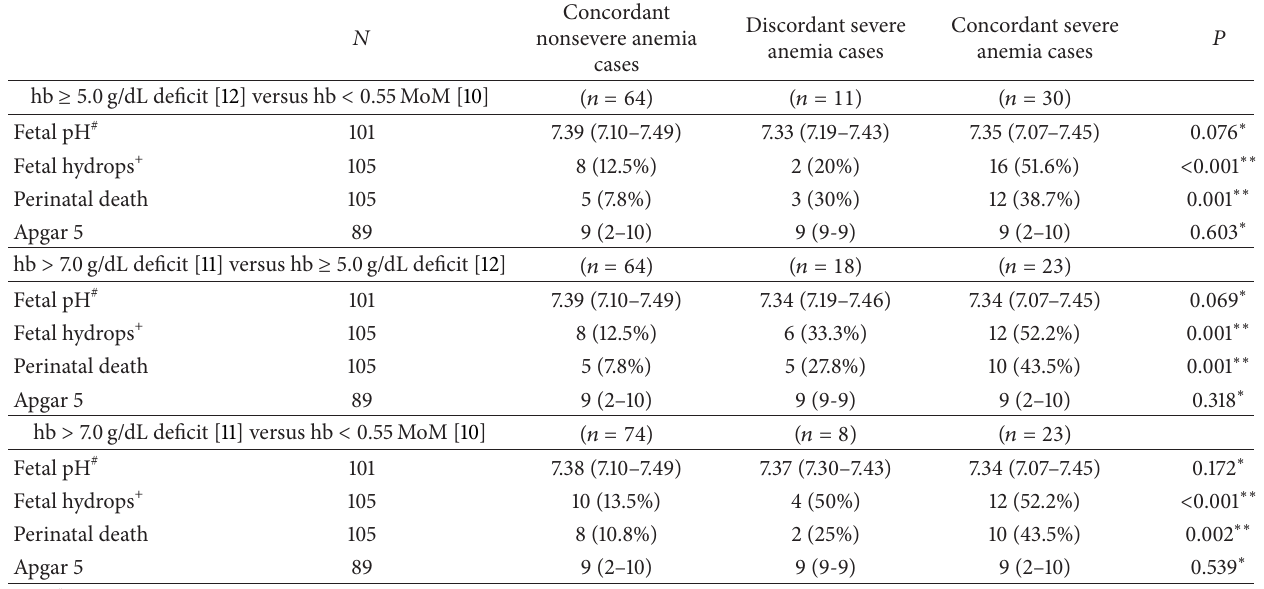
Table 2: Perinatal outcome, according to concordance in classifying anemia severity using the several criteria analyzed.